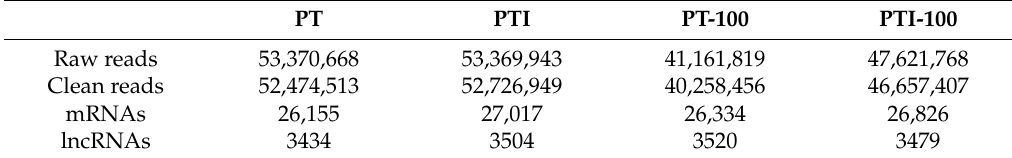
Table 1. Statistical data of the RNA-Seq